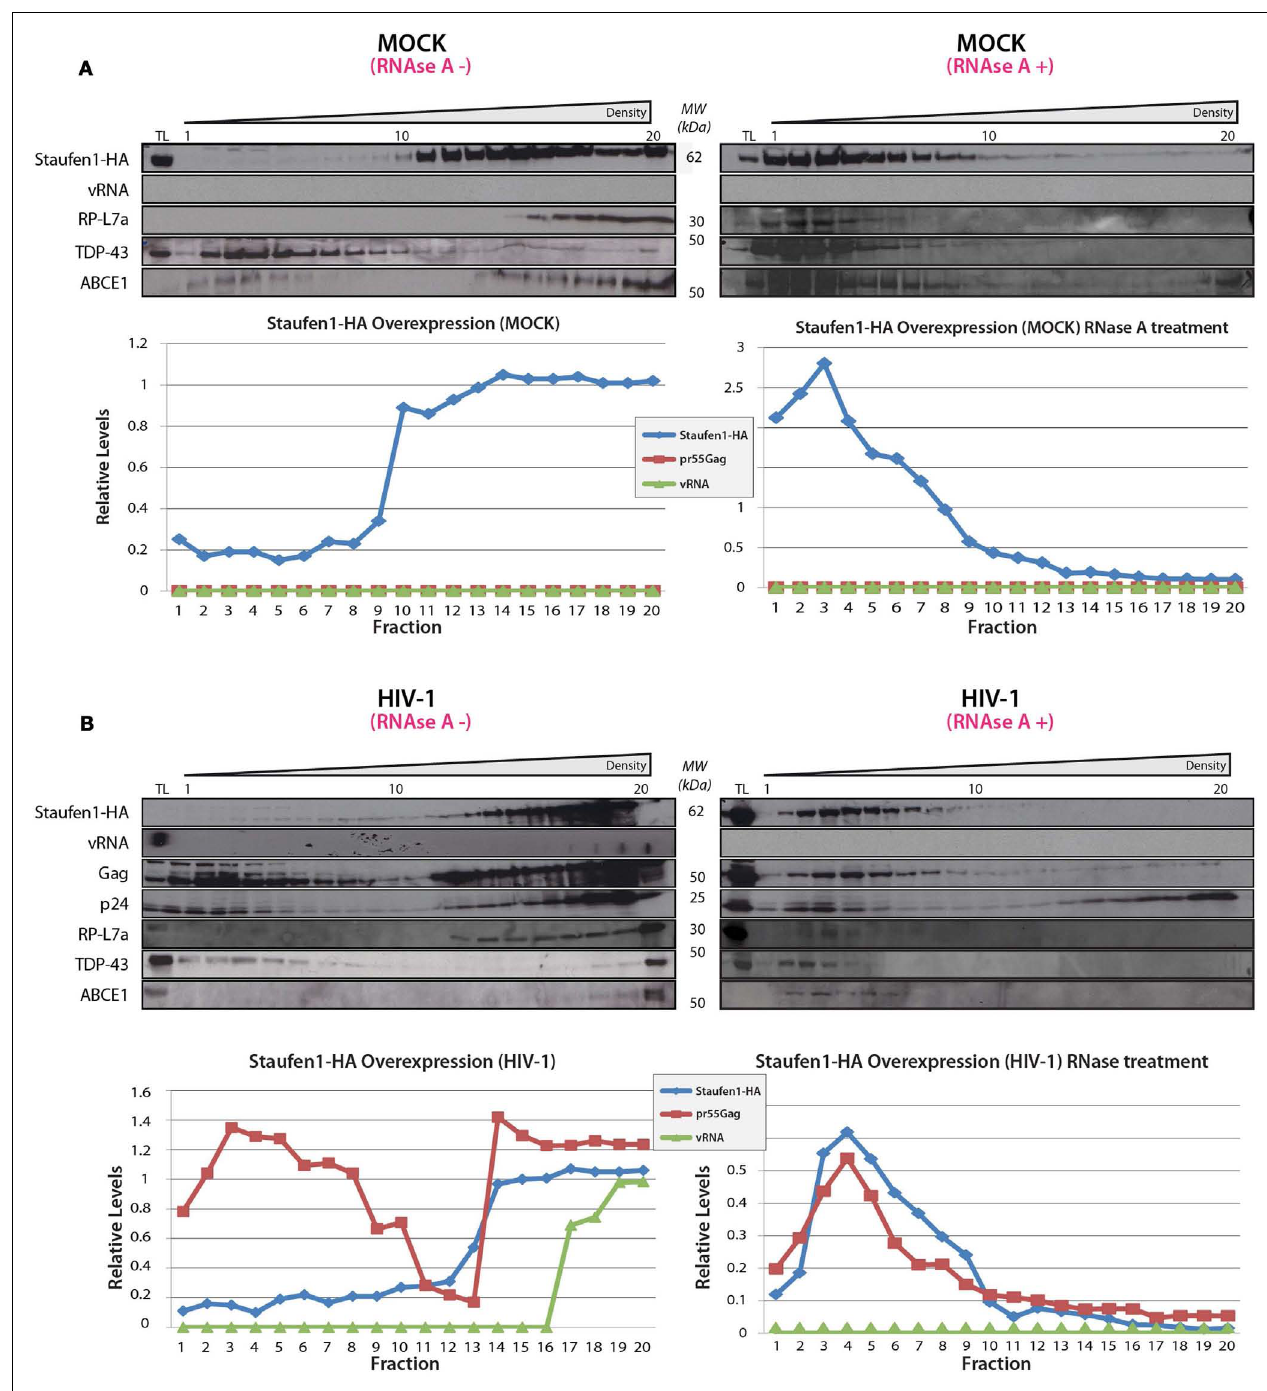
assessed in each fraction by slot blot analysis.TL represents the total lysates. (B) HeLa cells were co-transfected with pNL 4–3 and Staufen1-HA.The presence of Staufen1-HA, precursor Gag and p24 were assessed in each fraction by western blotting analysis. HIV-1 viral genomic RNA (9kb, vRNA) was assessed in each fraction by slot blot analysis. Staufen1, Gag and vRNA were quantitated in each fraction by densitometry and relative levels are depicted for each fraction (Blue: Staufen1-HA, Red: Gag,